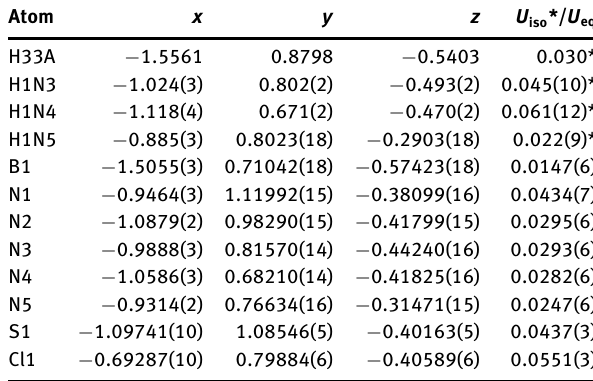
Table 2: Fractional atomic coordinates and isotropic or equivalent isotropic displacement parameters (Å 2